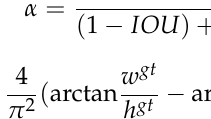
Figure 2. Target frame distance diagram. c represents the diagonal distance of the smallest closed area which contains both the predicted bounding box and the ground truth. d represents the dis- tance in Euclidean space between the predicted bounding box’s center point and the ground truth’s center point. The formula for calculating CIOU is shown as follows: 2